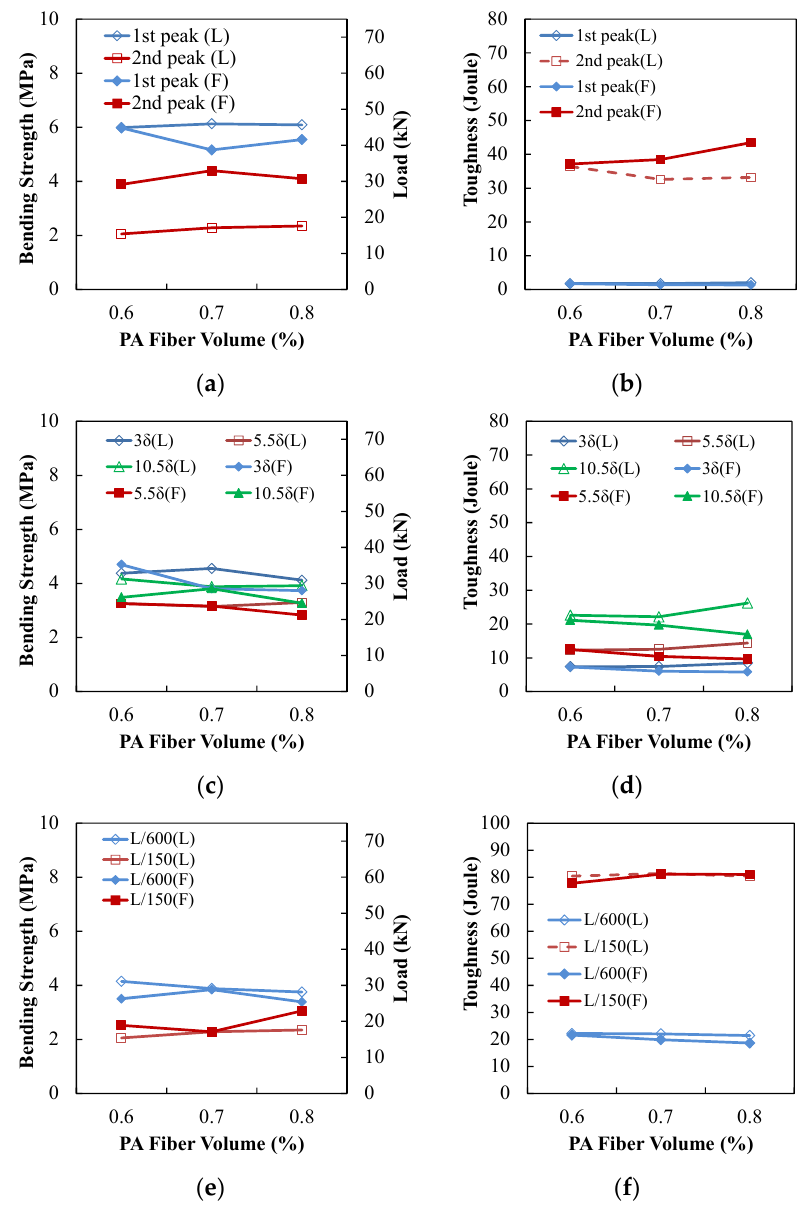
Figure 9. ( a ) Bending strength (first and second peaks); ( b ) toughness (first and second peaks); ( c ) bending strength (3 δ , 5.5 δ , 10.5 δ ); ( d ) toughness (3 δ , 5.5 δ , 10.5 δ ); ( e ) bending strength (L/600, L/150); ( f ) toughness (L/600, L/150).